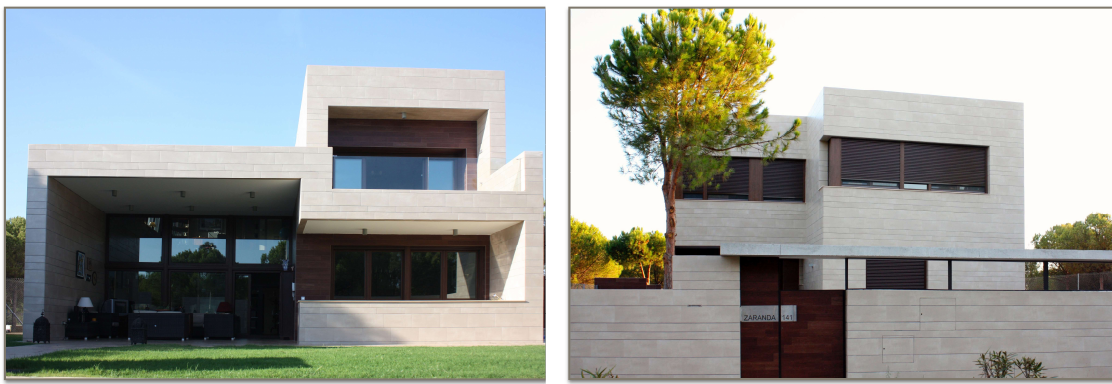
Figure 20. In the photo left and right , respectively: elevations south and north of Casa Zaranda. Final